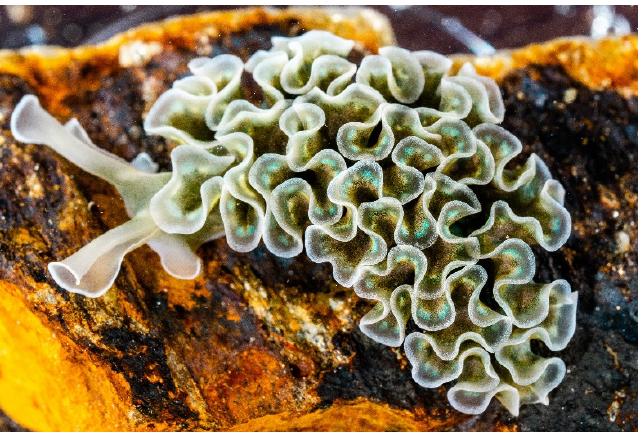
Figure 1. The sacoglossan sea slug Elysia crispata with its exuberant lateral folds (parapodia). The green coloration is due to the presence of chlorophyll within functional chloroplasts stolen from its algal food sources.